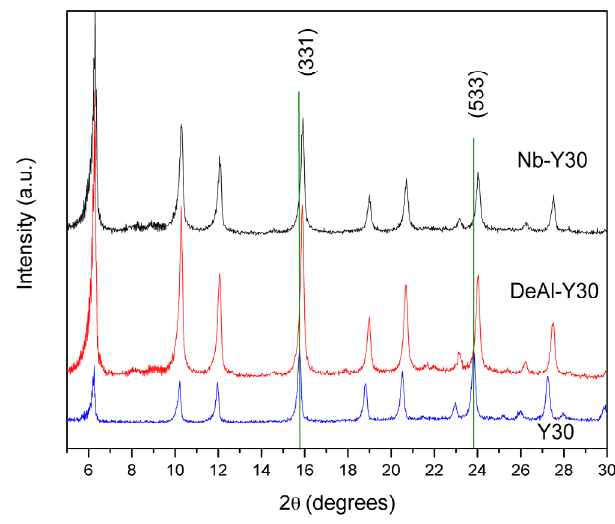
Figure 4. X-ray powder diffraction patterns of pristine H-USY CBV-600 (Y30), dealuminated H-USY CBV-600 (DeAl-Y30) and inserted Nb in dealuminated H-USY CBV-600 (Nb-Y30) samples (green lines help for the visualization of the shift of reflections (331) and (533)).